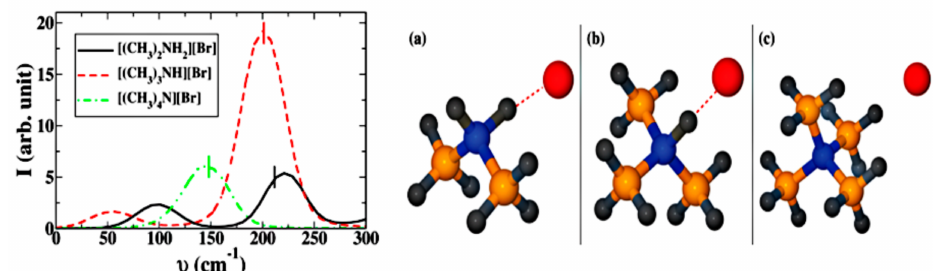
Figure 2. Far-IR spectra (left) and ion pairs geometries (right) of three alkylammonium salts: ( a ) [(CH 3 ) 2 NH 2 ]Br, ( b ) [(CH 3 ) 3 NH]Br, and ( c ) [(CH 3 ) 4 N]Br [40]. Reprinted with permission of American Chemical Society.